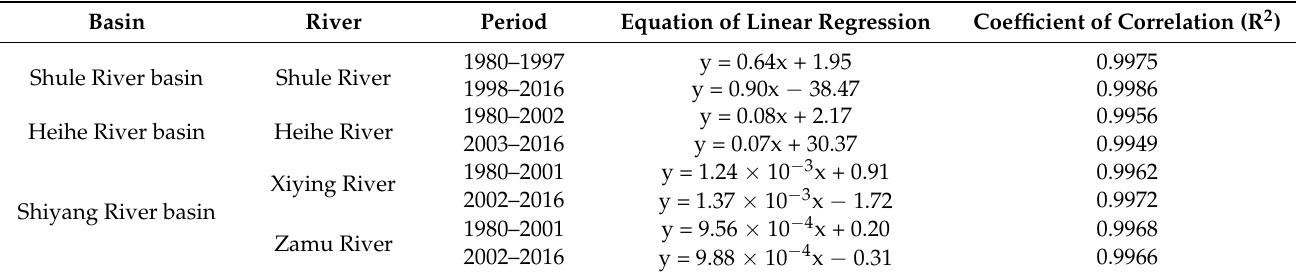
Table 7. The variability of the double-mass curve in the different periods in the Hexi inland rivers basin.